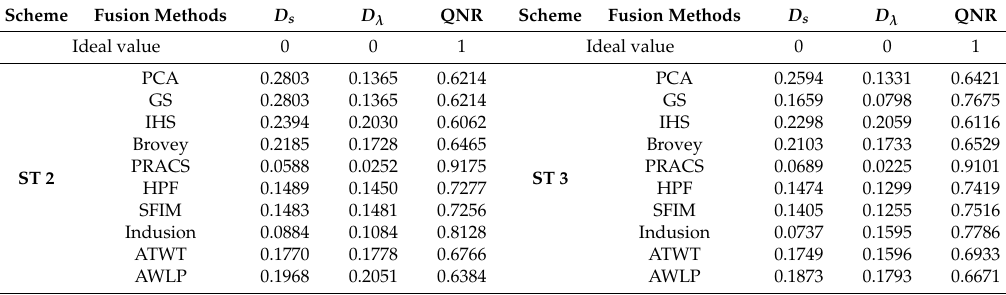
Figure 3. The original Landsat MS image ( a ), 15 m PAN image ( b ), reference image ( c ) and fused MS images ( d – w ) produced in strategy (ST) 2 and ST 3. (R: NIR band, G: Red band, B: Green band). Table 2. D s , D λ and QNR of the fused MS images generated by different pansharpening algorithms in strategy 2 (ST2) and strategy 3 (ST3).